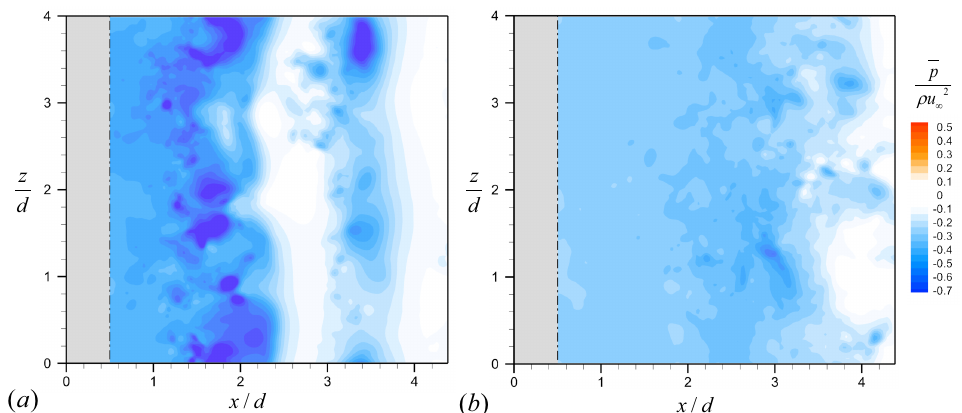
Figure 11. Instantaneous pressure contours of flow over a circular cylinder with and without tabs on the centerplane ( y = 0) in the wake: ( a ) cylinder without a tab; ( b ) cylinder with tabs of l y / d = 0.2 and l z / d = 0.3.